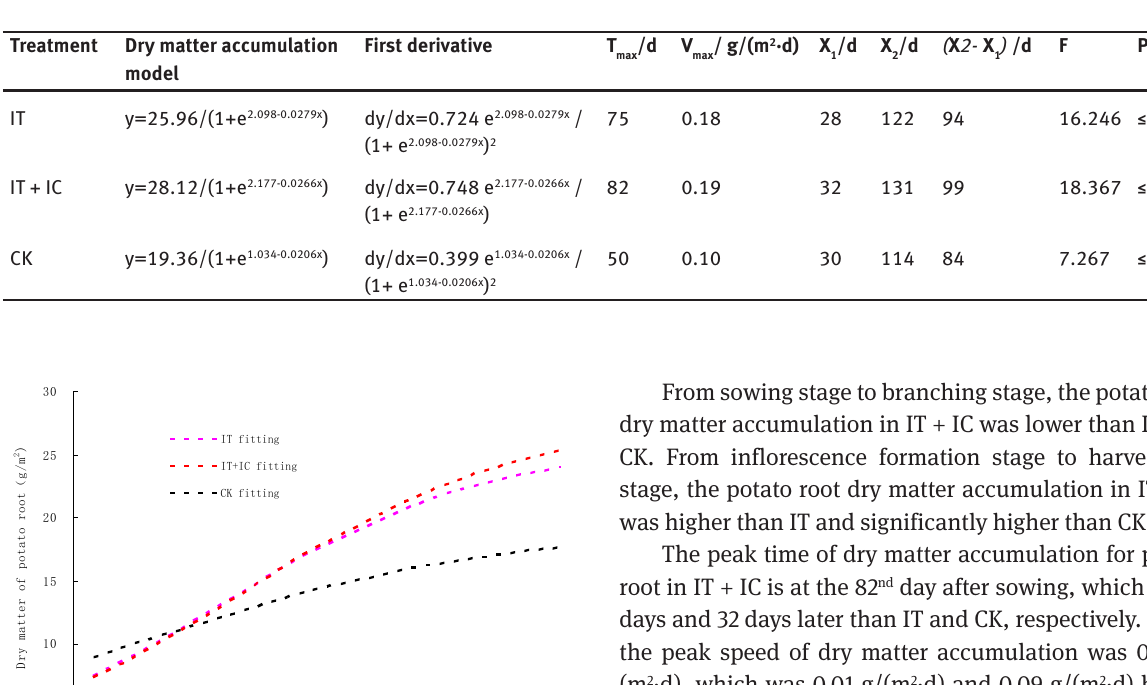
Table 5: Dynamic simulation and characteristic parameters of dry matter accumulation for potato root in different